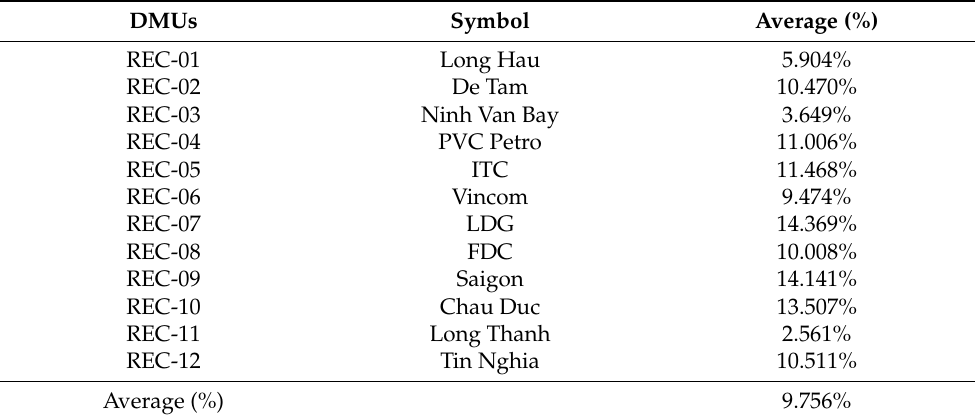
Table 5. The average MAPE of